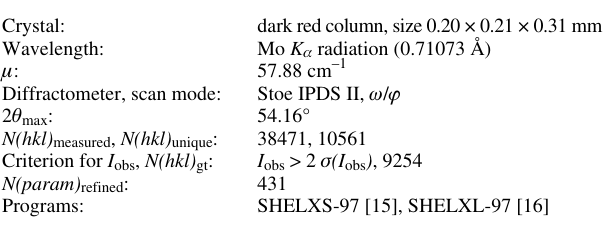
Table 1. Data collection and